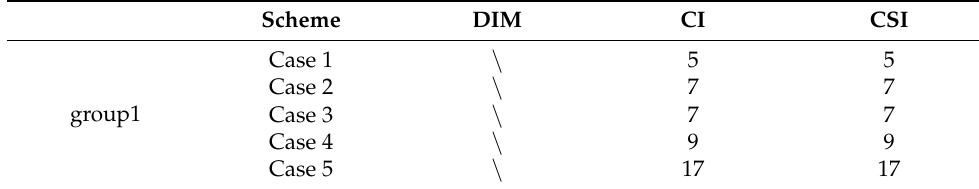
Table 1. The IPs with different inversion schemes in the first group of experiments.